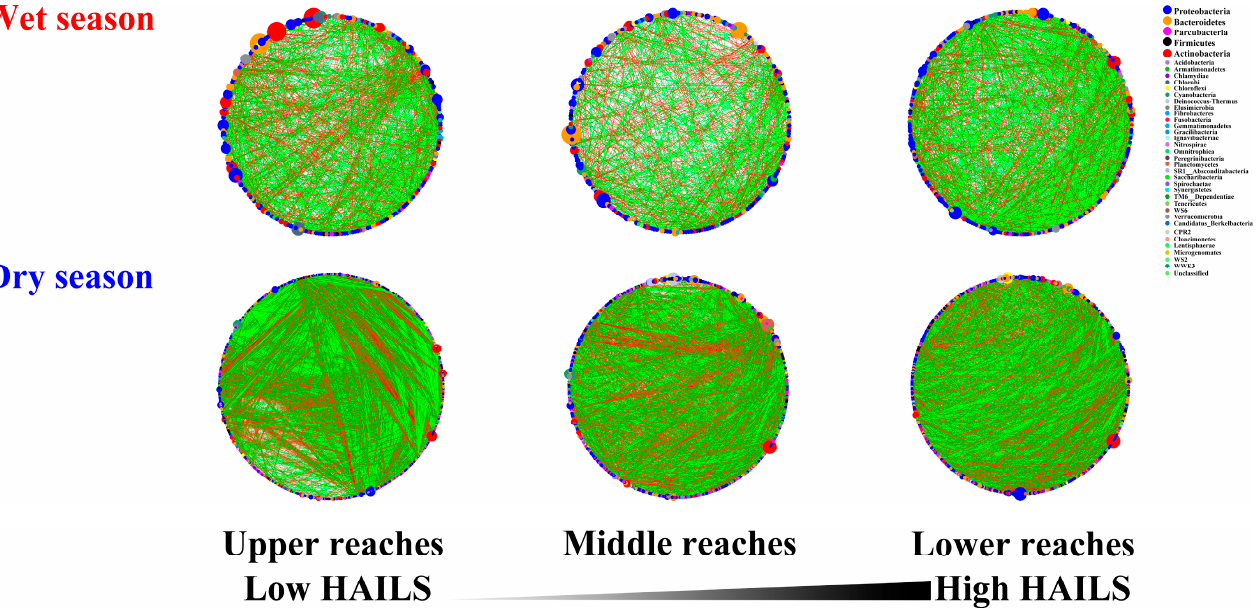
Figure 3. Molecular ecological networks of bacterial communities during the wet and dry seasons on Yuan River. Green and red lines denote significant positive (Spearman correlation, p < 0.05, r > 0.8) and negative (Spearman correlation, p < 0.05, r < − 0.8) linear relationships, respectively. The size of the circles represents the relative abundances of bacteria and the black line represents the categorical stress rankings of the three environments along the human activity intensity on the land surface.